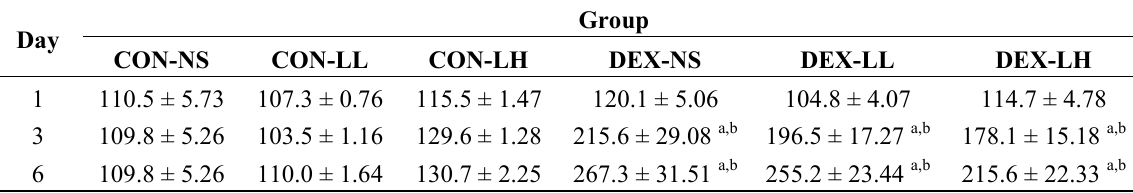
Table 2. Fed serum glucose (mg/dL) of the experimental groups on days 1, 3 and 6 of the study.